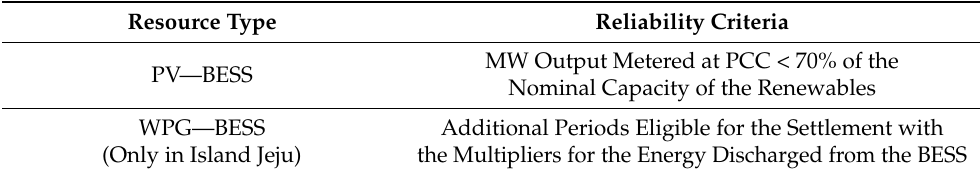
Table 2. Reliability constraints amended for the coordinated renewables.